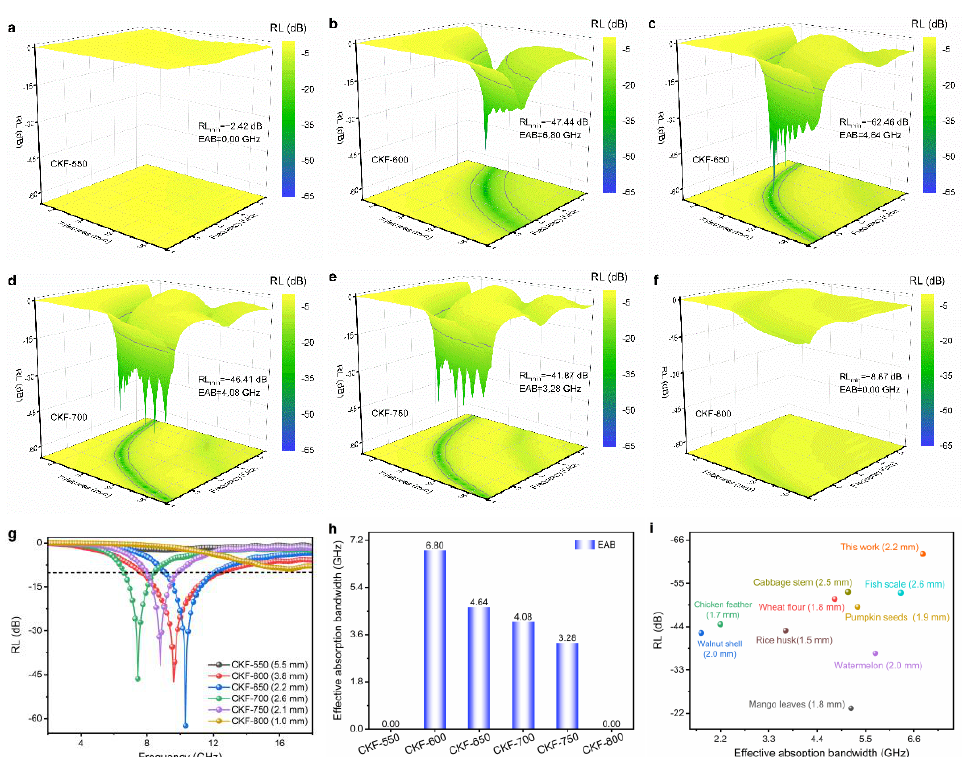
Figure 5. ( a – f ) Three-dimensional depictions of RL plots for CKF-based absorbers with different thicknesses and frequency; ( g ) RL curves and ( h ) effective absorption bandwidth of CKF at the optional thickness; ( i ) comparison of the MA capacity of reported biomass-derived carbon.